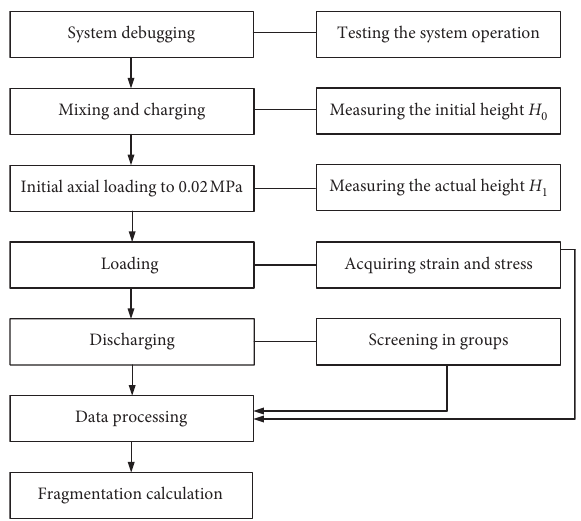
Figure 5: Test procedure.